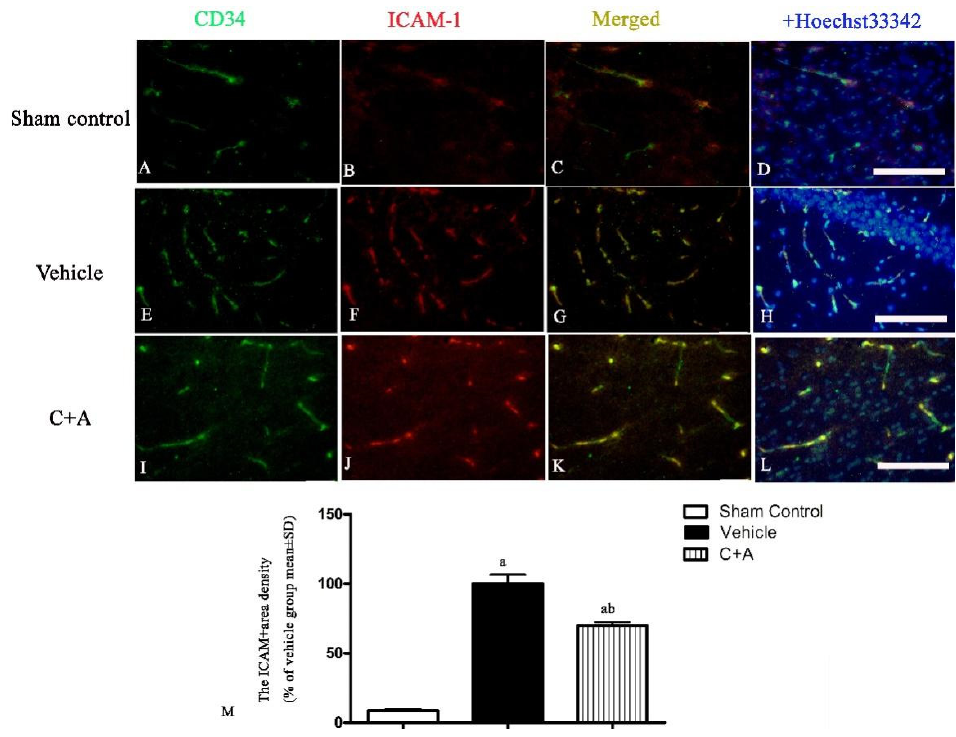
Figure 3. ( A – L ): Double immunofluorescence staining of microvessel marker CD34 (green) and ICAM-1 (red) in all groups. The nuclei were visualized by Hoechst 33342 staining (blue). ( M ) Quantitation of ICAM-1-labeled microvessels showed that treatment with C16 plus Ang-1 reduced the amount of ICAM-1-labeled vessels in AD rats. Scale bar = 100 µm. a, p < 0.05 vs. sham control group; b, p < 0.05 vs. vehicle group.